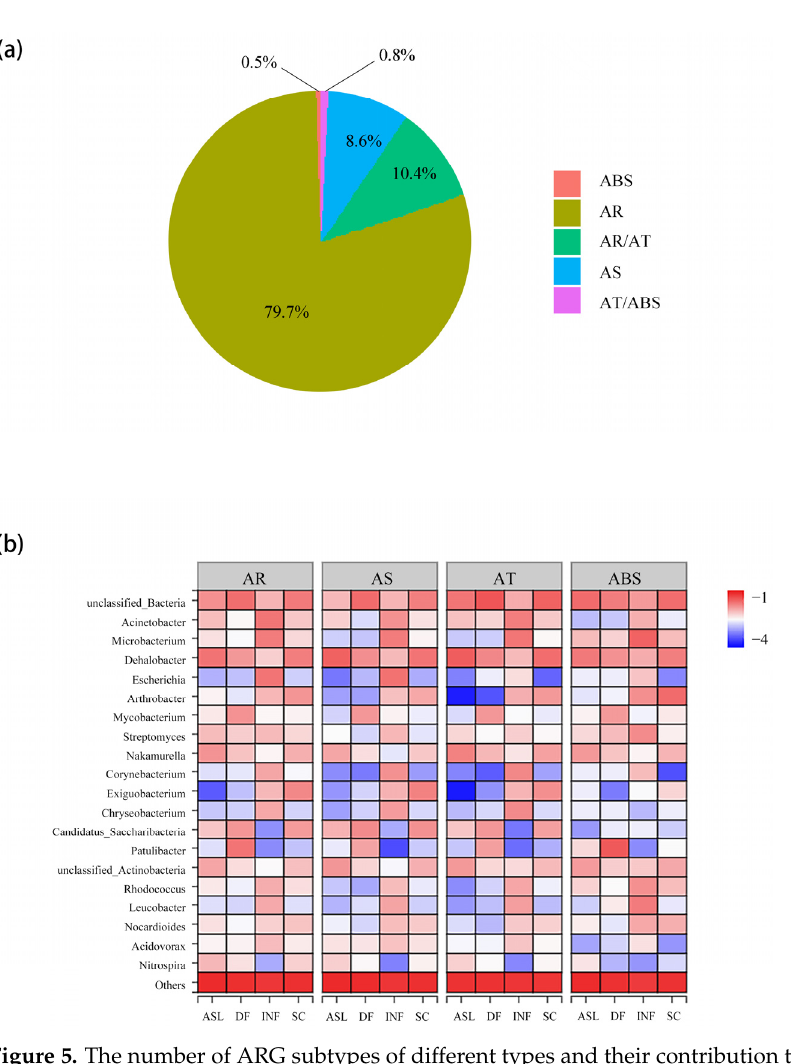
Figure 5. The number of ARG subtypes of different types and their contribution to bacteria. ( a ) The proportion of ARG subtypes to the antibiotic resistance types; ( b ) contribution of bacteria at genus level to the four types of antibiotic resistance.